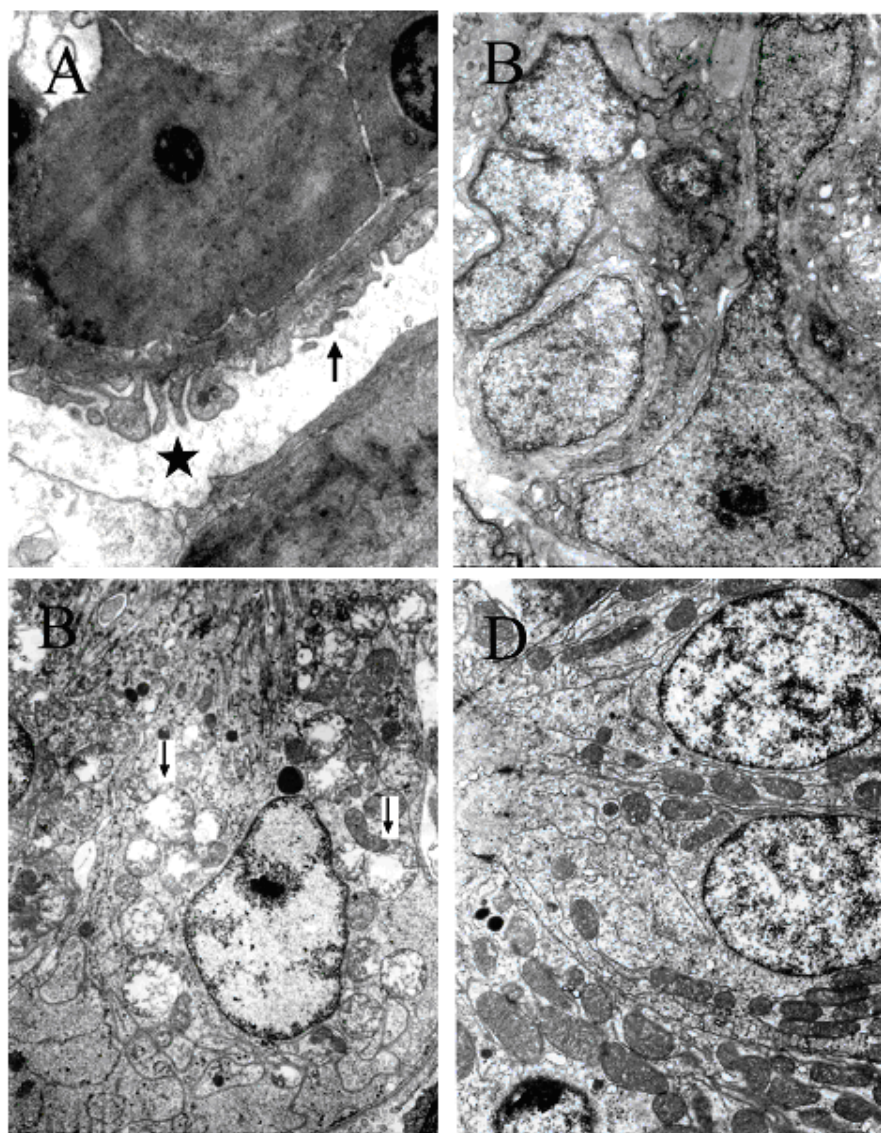
FIGURE 6. Transmission electron micrograph of the kidney of bighead carp collected from the fish pen in Meiliang Bay of Taihu Lake during July (A and C) and December (D and E), 2004. (A) Dilation of Bowman’s capsule in glomeruli (asterisk) and inosculation of foot processes in epithelial cell of glomeruli (arrows), 10,000×; (B) proliferation of mesangial cells in glomeruli, 10,000×; (C) deformation of nuclei and hydropic mitochondria with pale matrices in proximal tubular cells, 6000×; (D) normal proximal tubular cells with elliptical nuclear and rich mitochondria, 6000×.